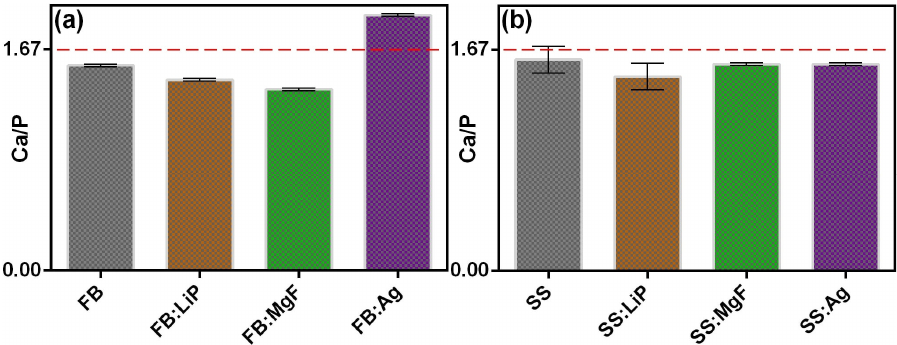
Figure 2. The value of the Ca/P ratio in the case of simple and doped FB ( a ) and SS ( b ) thin fi lms.